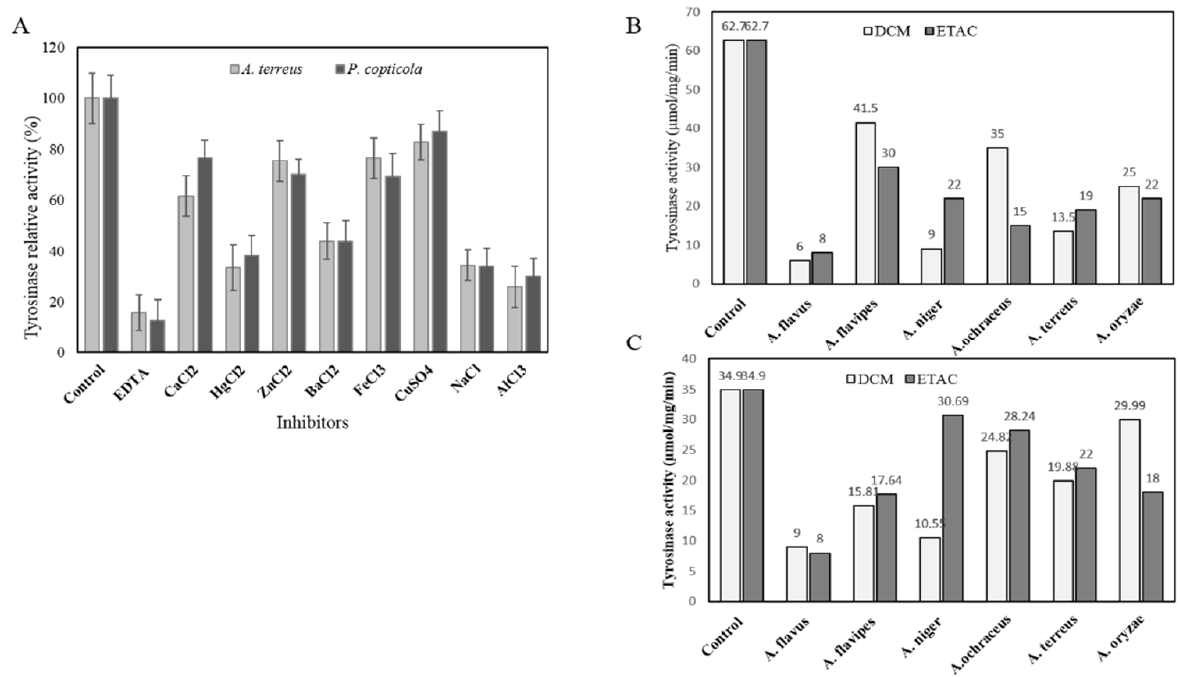
Figure 5. Effect of different metals inhibitors and extracts of different fungal extracts on the purified tyrosinase activity from A. terreus and P. copticola. The enzyme was preincubated with different cations metals for 2 h, then the residual enzymatic activity was determined by the standard assay. Six fungal isolates ( A ) . flavus, A. flavipes, A. niger , A. ochraceous , A. terreus and A. oryzae ) were grown for 10 days on PDB media, then the filtrates were extracted with dichloromethane and ethyl acetate. The enzyme was preincubated with the fungal extracts for 2 h, then the residual enzymatic activity from A. terreus ( B ) and P. copticola ( C ) was measured by the standard assay.